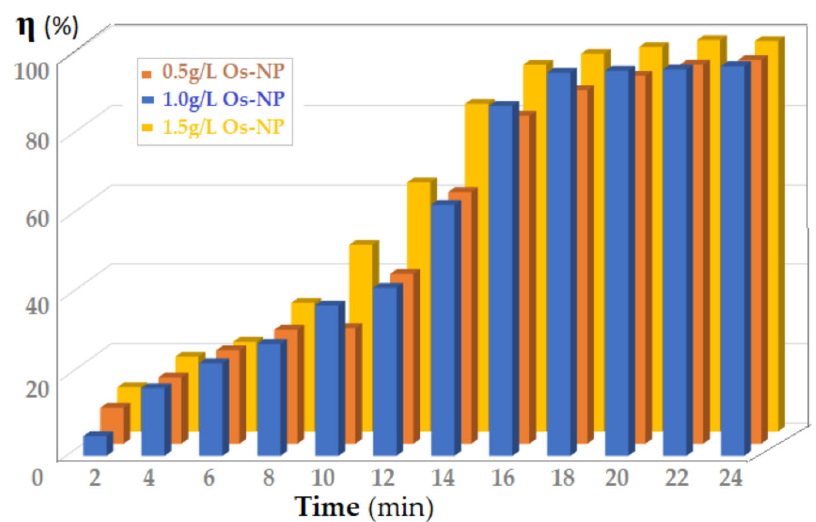
Figure 11. The variation in p –nitrophenol conversion ( η ), depending on the flow rate of the source phase (1000 mL) and the contact time with the membrane phase containing either 0.5, 1.0 or 1.5 g/L osmium nanoparticles (Os–NP).